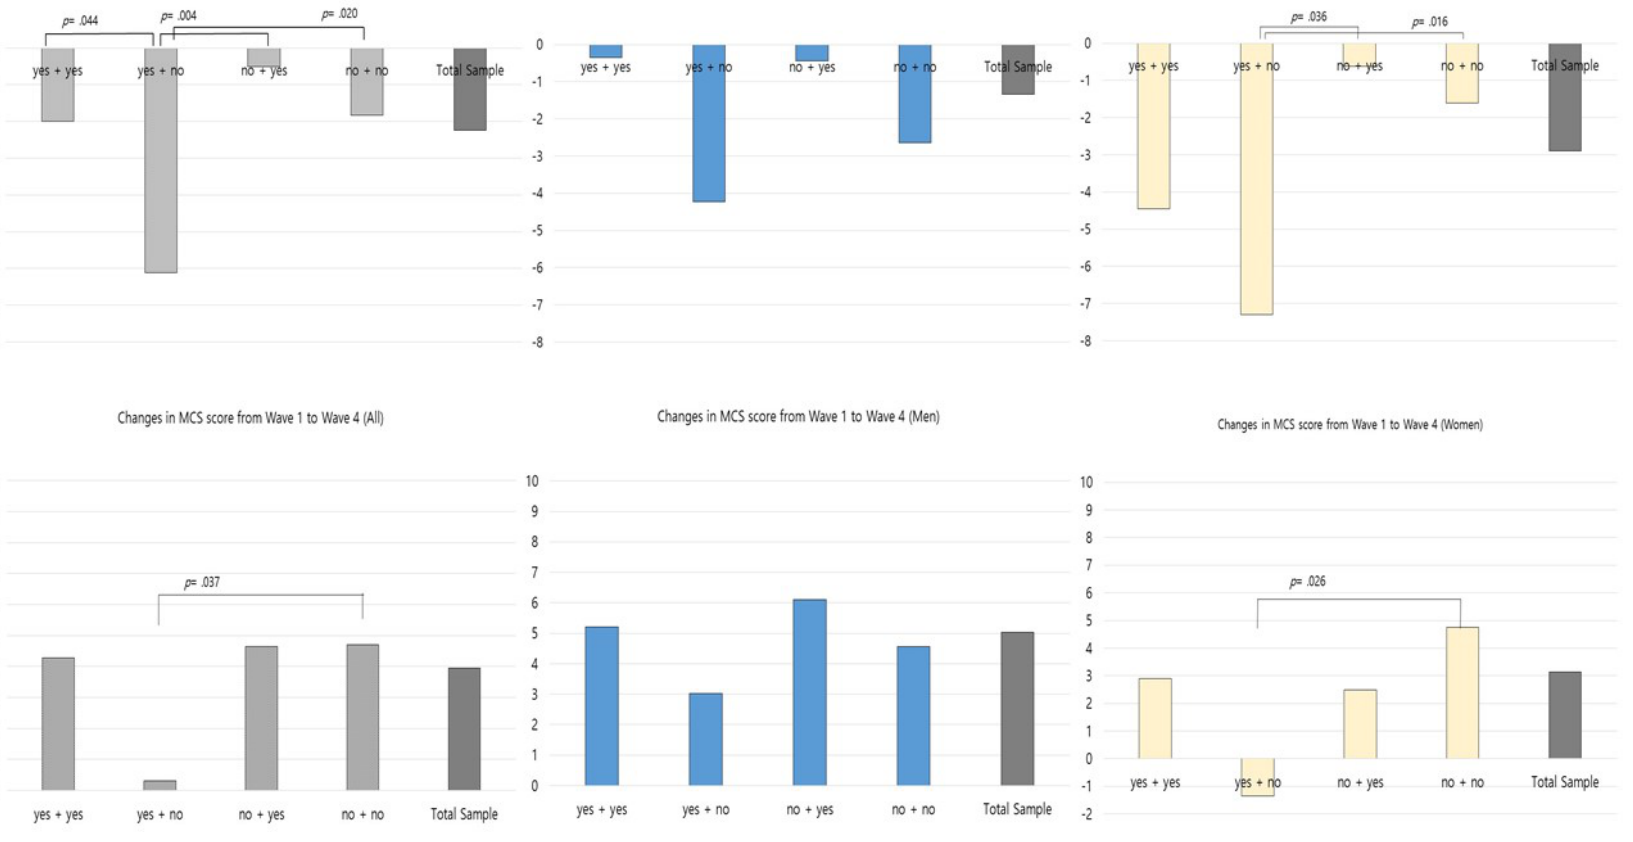
Figure 2. Differences in health-related quality of life between the baseline and follow-up according to changes in meeting friends. Note 1. MCS = Mental Component Summary; PCS = Physical Component Summary.